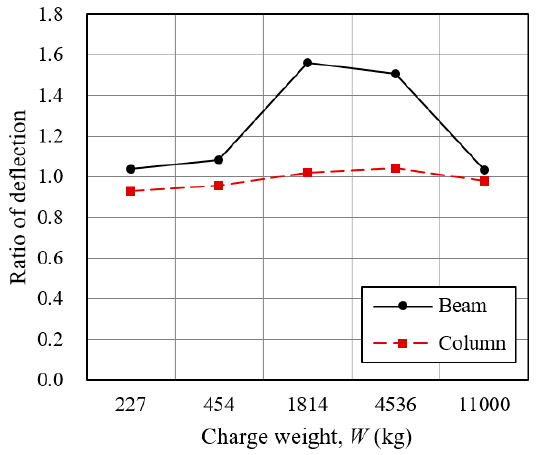
Figure 17. Deflection ratio of through-diaphragm to plate-reinforced connection.